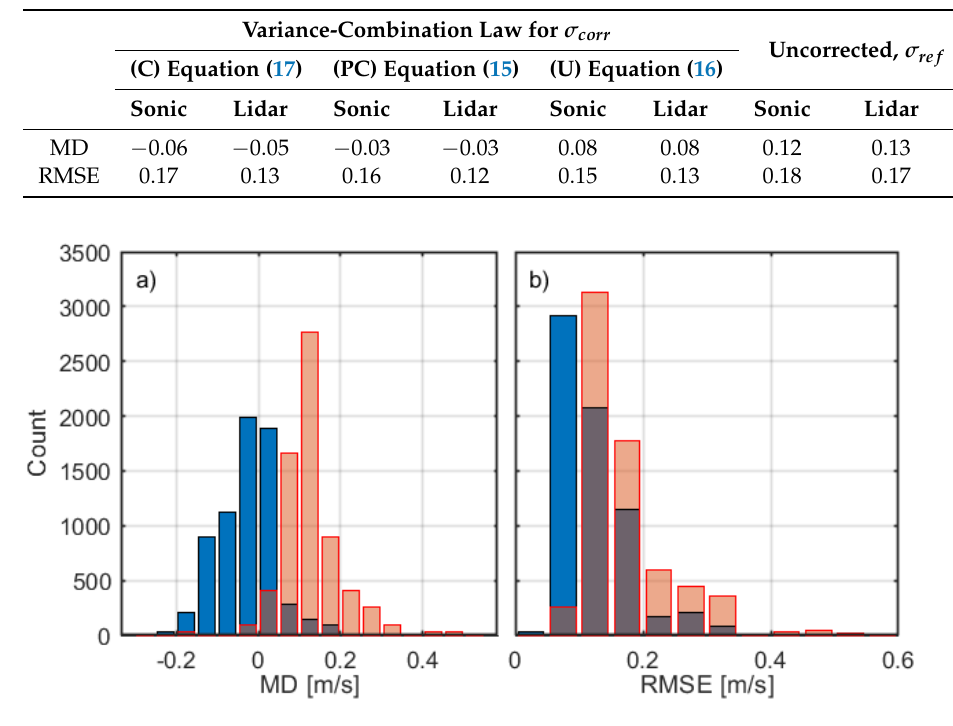
Figure 6. Histogram of the main statistical parameters. ( a ) mean difference; ( b ) root mean square error using the fixed lidar as reference; for all panels: blue = motion corrected, red =